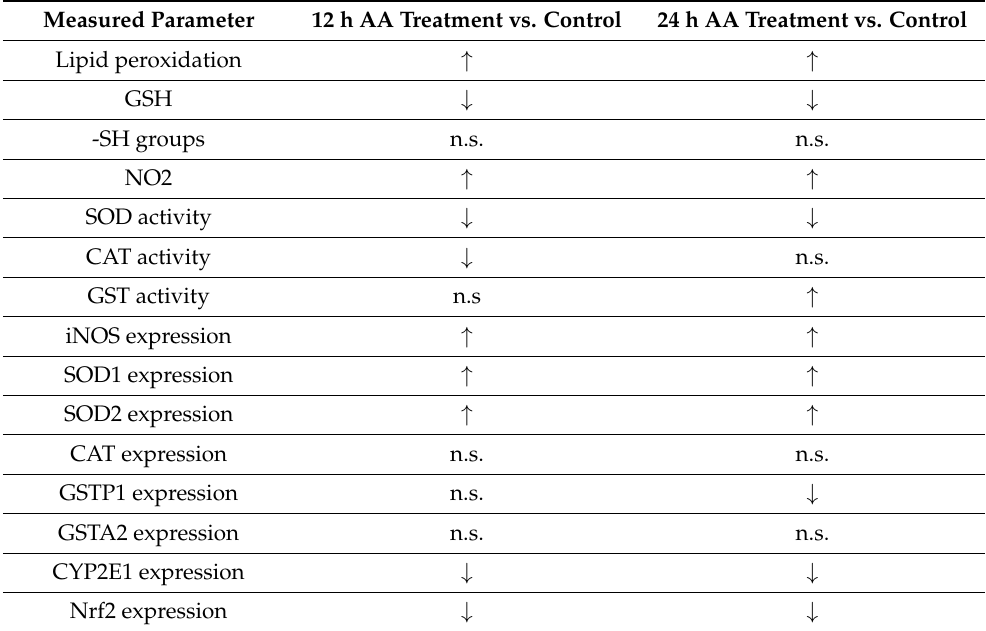
Table 2. Effect of AA treatment on toxicity parameters in pancreatic beta-cell line Rin-5F. Rin-5F cells were treated with IC 50 AA for 12 and 24 h [72]. Measured Parameter 12 h AA Treatment vs. Control 24 h AA Treatment vs.